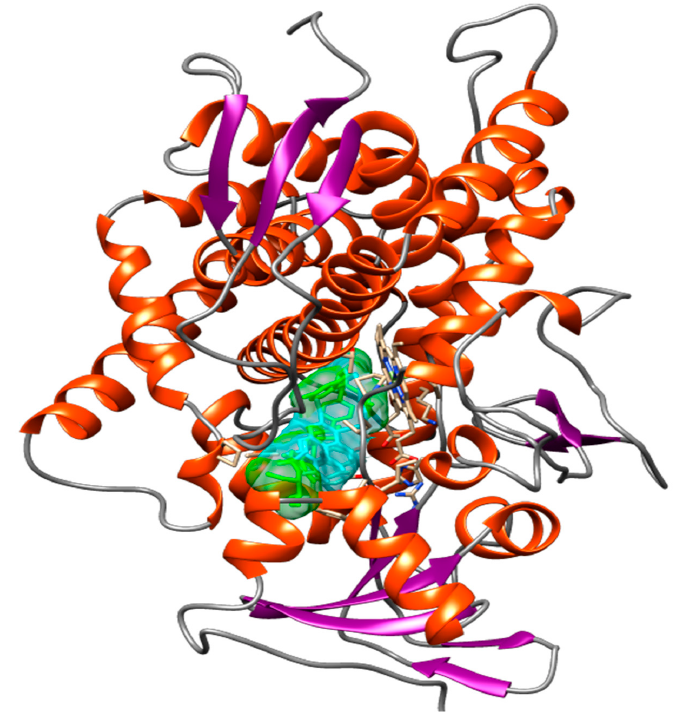
Figure 12. Spatial conformation showing several common binding sites between the CaCYP51 enzyme (PDB: 5FSA) and Vismione D (blue) or the antifungal posaconazole (green) through molecular docking. The image was obtained with USCF Chimera.